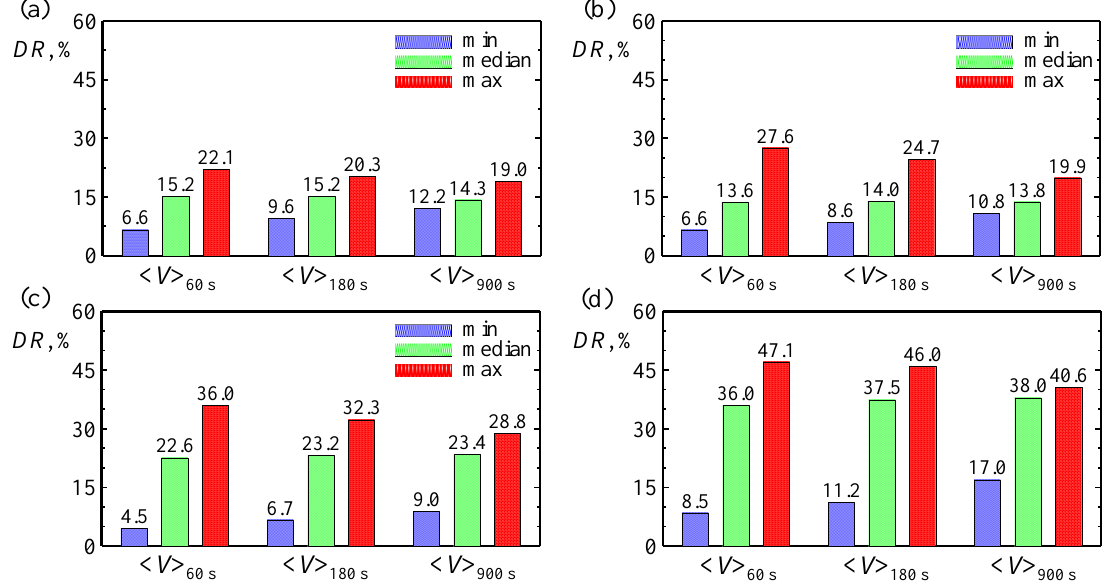
Figure 11. Range of DR variation for three different averaging periods at four monitoring points: ( a ) z = 0.1 m, ( b ) z = 0.6 m, ( c ) z = 1.1 m, and ( d ) z = 1.7 m (data for θ = 25°, case #1).